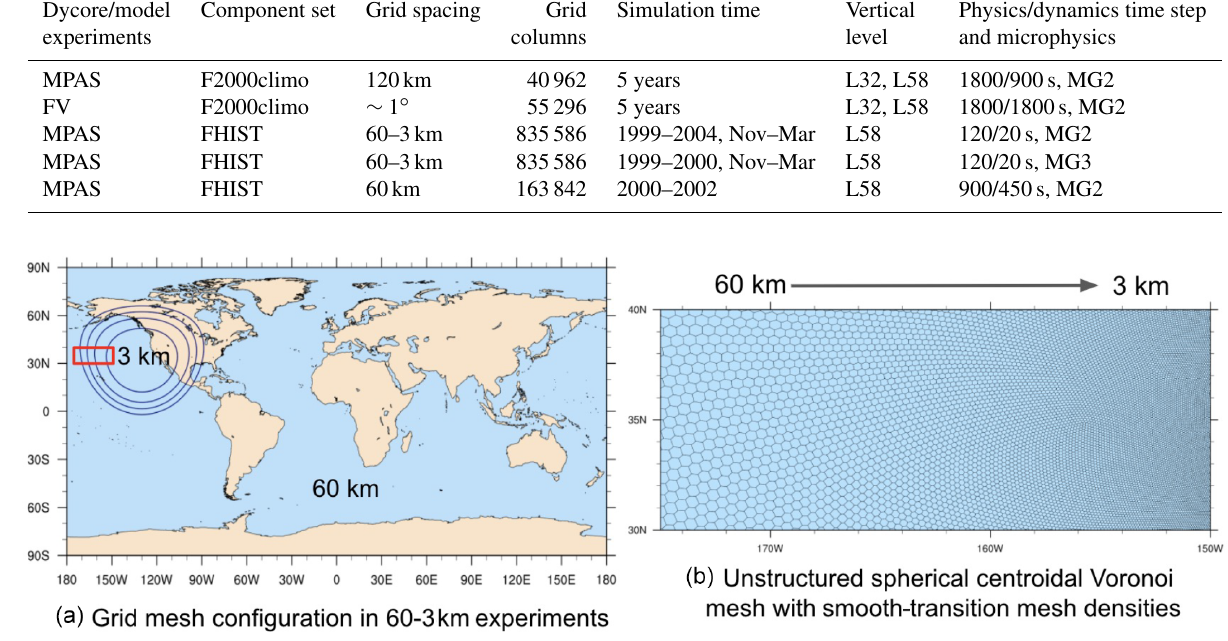
Figure 1. SIMA-MPAS mesh configuration for the 60–3km experiments. (a) The global-domain mesh configuration with total grid columns of 835586; (b) the zoomed-in region (see the red box depicted in panel a ) for the mesh structure from 60 to